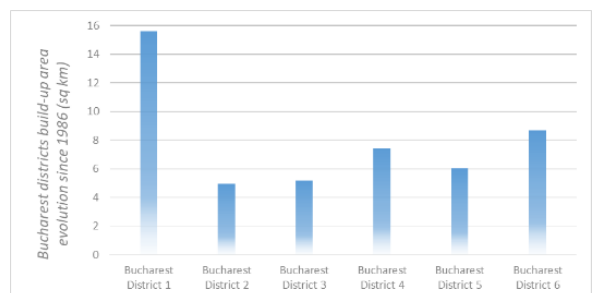
Figure 8 . Bucharest’s built-up area evolution by districts between 1986 and 2015 (data extracted from the WSF Evolution dataset created by DLR)